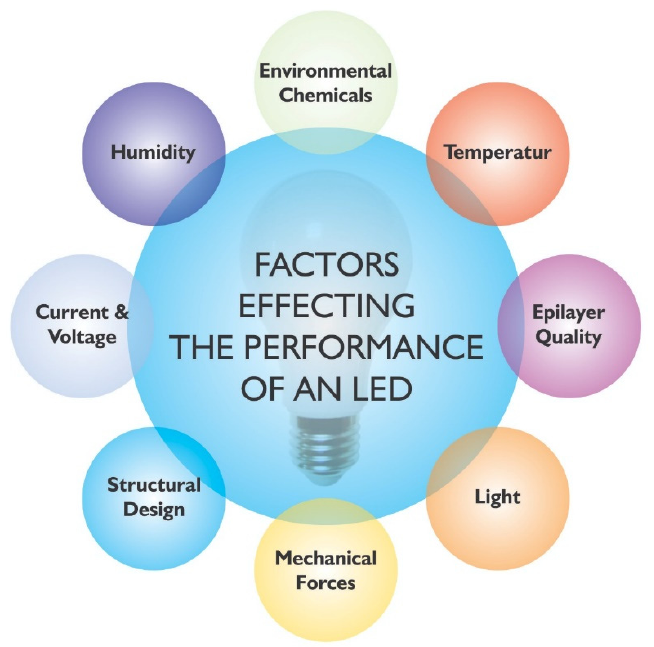
Figure 1. Factors effecting LED reliability.